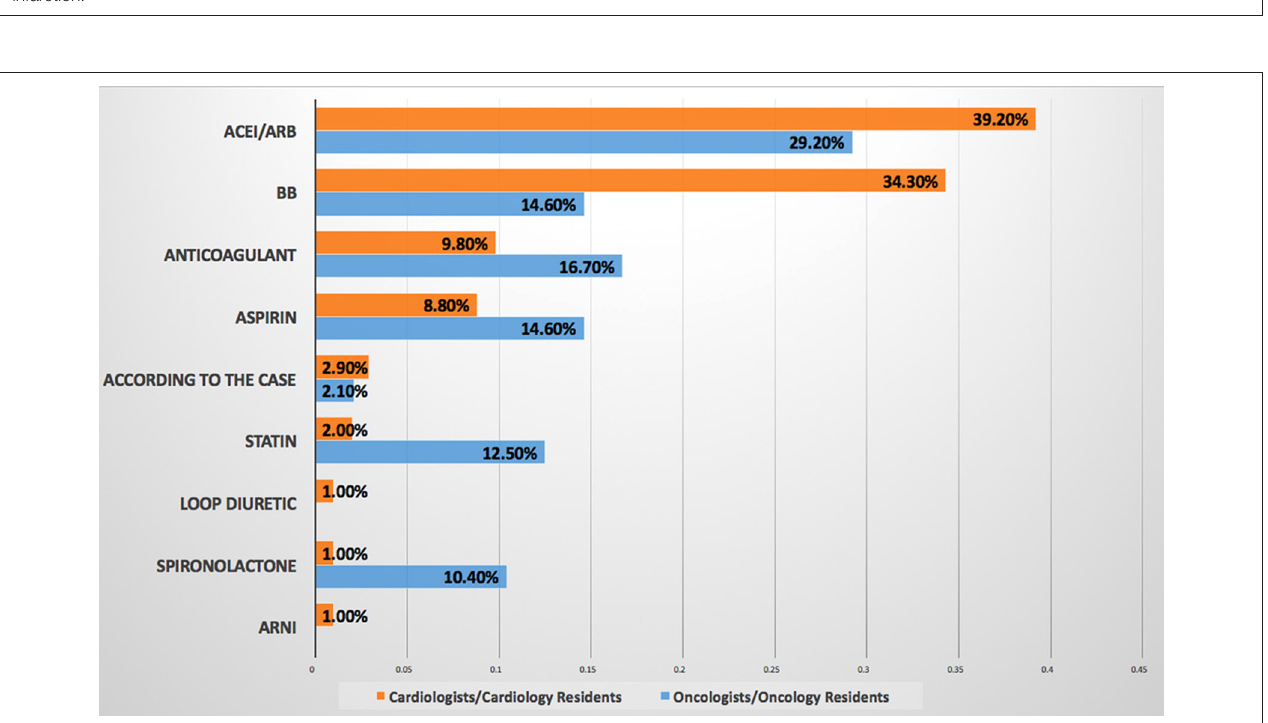
FIGURE 2 | Most commonly prescribed cardiovascular drug for patients with cancer. ACEI/ARB are the most commonly prescribed cardiovascular drug for patients with cancer by both cardiologists/cardiology residents and oncologists/oncology residents. ACEI, angiotensin-converting enzyme inhibitor; ARB, angiotensin receptor blocker; BB, beta-blocker; ARNI, angiotensin receptor-neprilysin inhibitor.